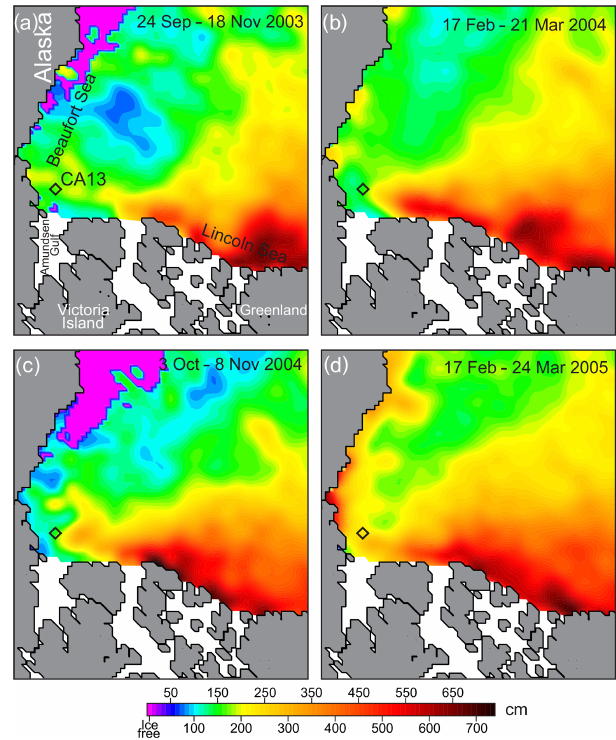
Figure 5. Spatial distribution of sea-ice thickness (cm) over the Canada Basin compiled using gridded sea-ice thickness data from ICESat campaigns for (a) 24 September–18 November 2003, (b) 17 February–21 March 2004, (c) 3 October–8 November 2004, and (d) 17 February–24 March 2005 following Kwok et al. (2009). The black diamonds depict the mooring